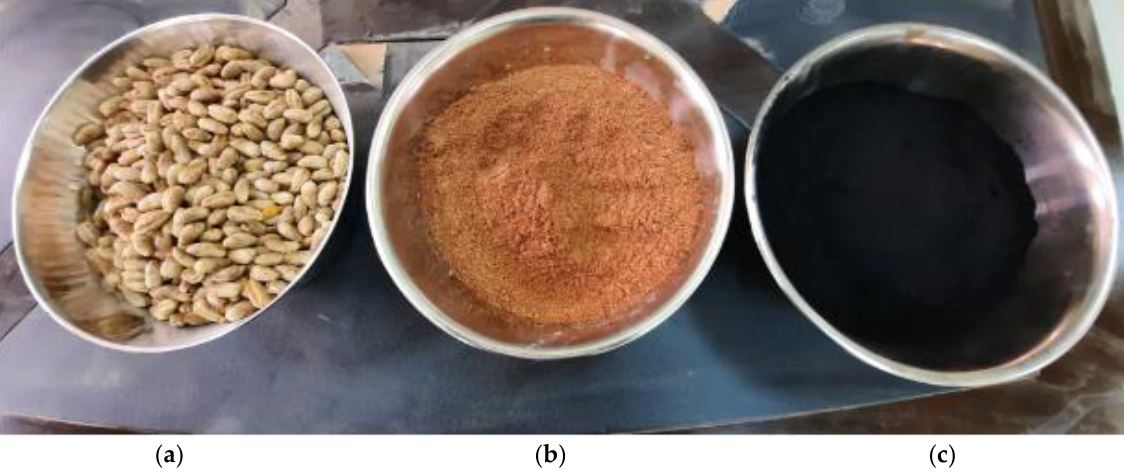
Figure 4. Physical appearance of date kernels. ( a ) Date kernels; ( b ) date kernel powder; ( c ) date kernel ash.